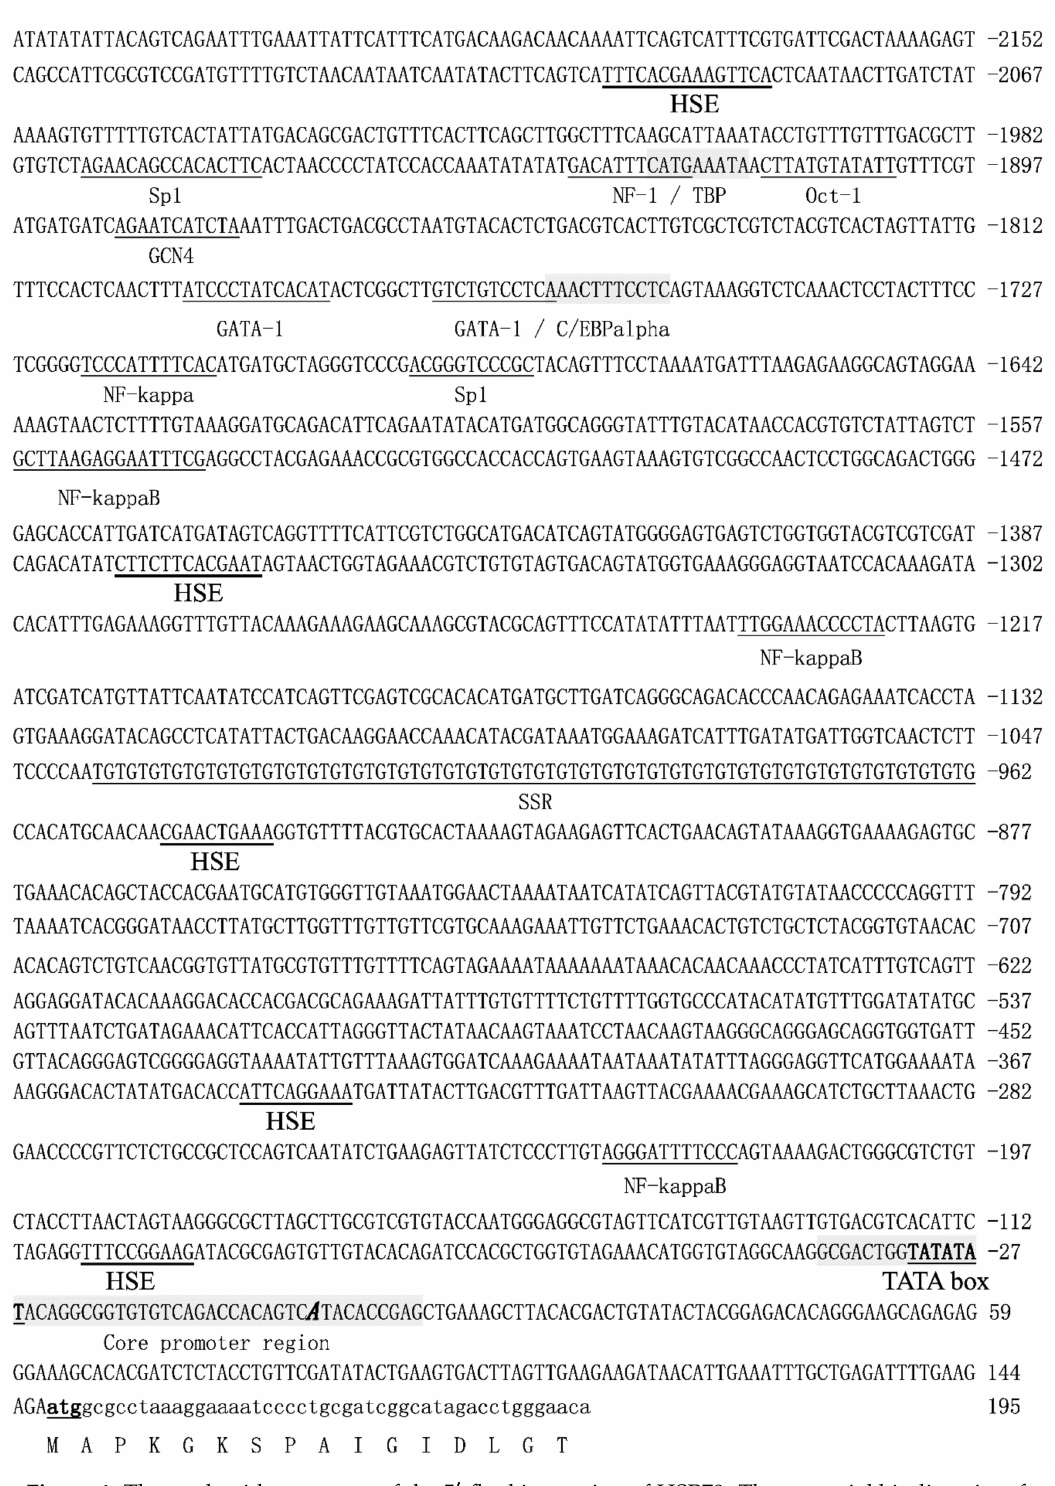
Figure 4. The nucleotide sequence of the 5 (cid:48) -flanking region of HSP70. The potential binding site of the transcription factors were marked with short thin line. Overlapping binding sites are indicated by shading. The predicted core promoter region is shaded, the transcription start site in bold letter, and is located at 1, and the translation start site (atg) in bolded and underlined. The heat-shock element HSE is marked with a short thick line and SSR with a long thin